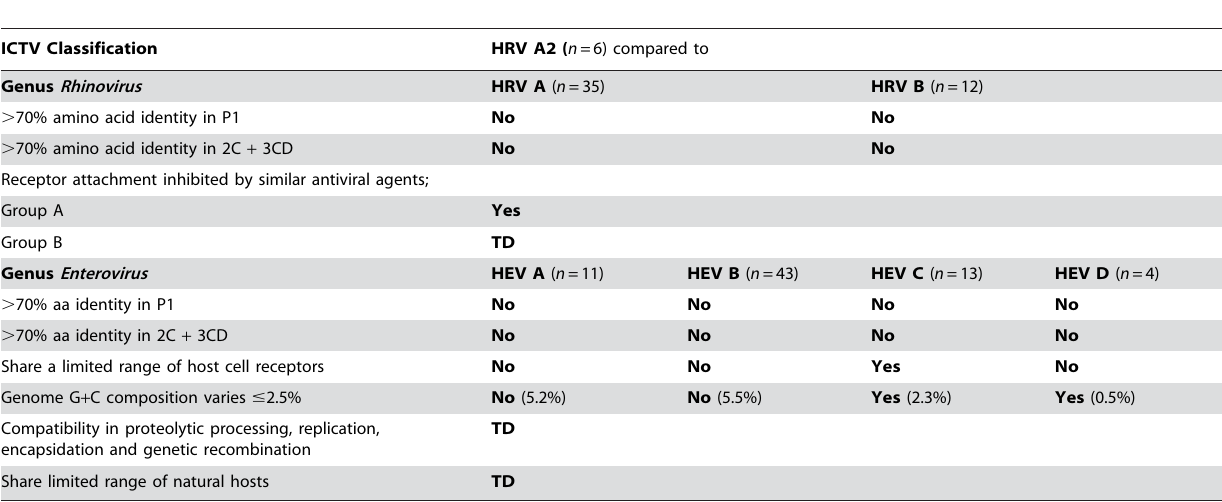
Table 3. Adherence of the newly identified HRV A2s to the ICTV species demarcation criteria.